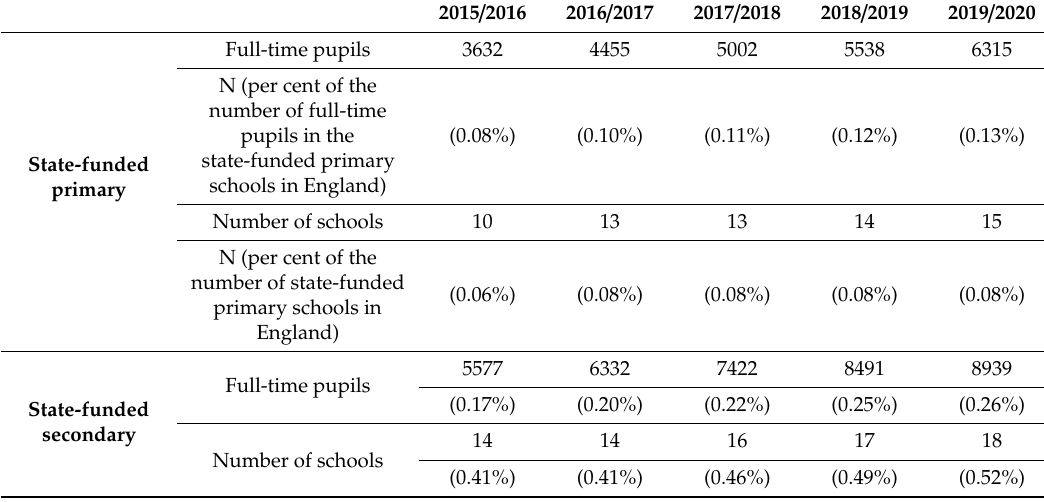
Table 1. State-funded Muslim schools in England between 2015 / 2016 and 2019 /